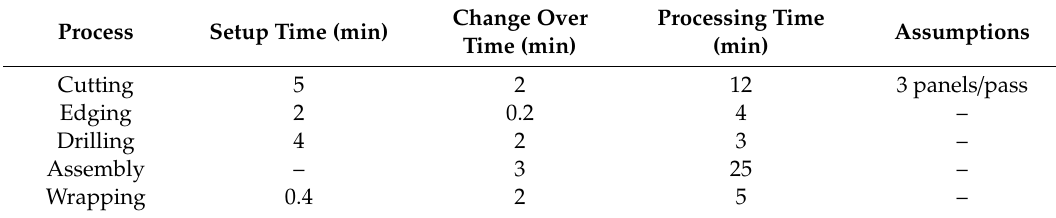
Table 2. Simulation Model